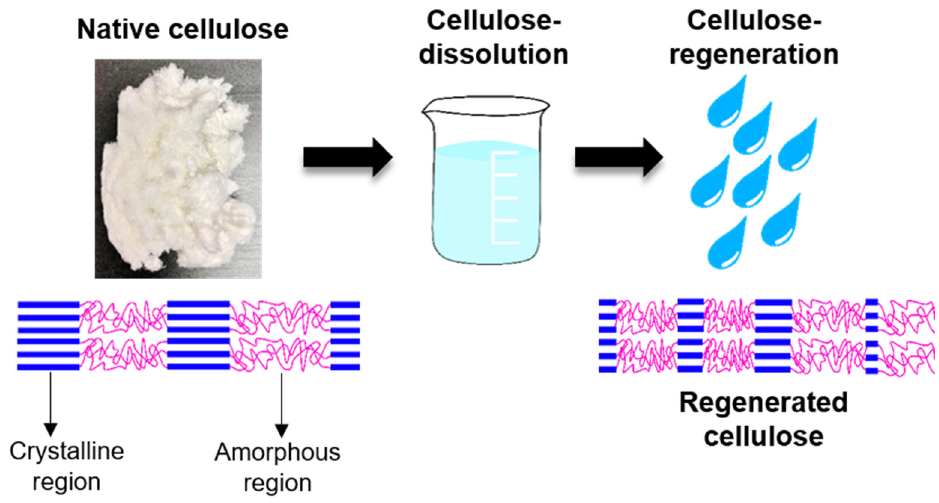
Figure 2. The dissolution-regeneration of native cellulose.